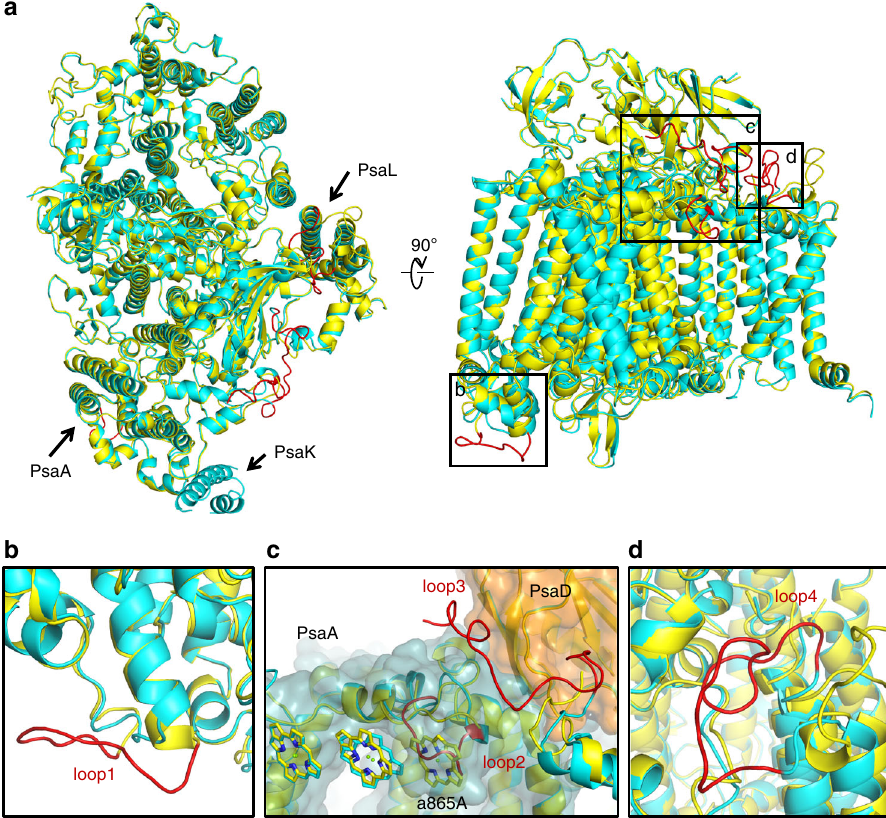
Fig. 2 Superposition of the structures of the white PSI and far-red PSI monomers. a Superposition of the white PSI (yellow) and far-red PSI (cyan) viewed along the membrane normal from the stromal side. The structural differences (loop insertions) are colored in red. The RMSD is 0.62 Å for 1855 C α atoms from subunits commonly observed between white PSI and far-red PSI. b – d Close-up view of the loop insertions at A232-D244 (loop1) of PsaA in white PSI b , P331-N338 (loop2) of PsaA in far-red PSI c , T8-L28 (loop3) of PsaL in far-red PSI c , and Q117-P134 (loop4) of PsaL in far-red PSI d . c PsaA (dark cyan) and PsaD (orange) are also shown as surface